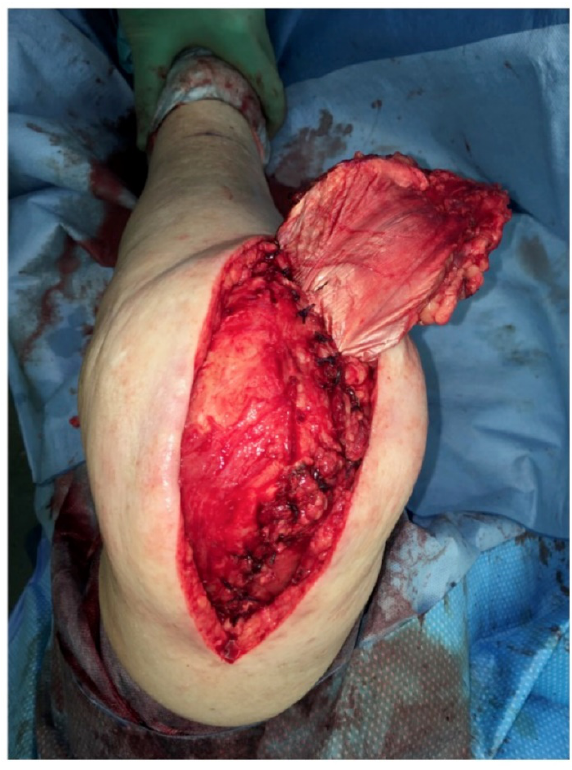
Figure 14: Pedicled MSAP gastrocnemius flap: Left knee in flexion while strengthening the medial capsule/patellar tendon lesion with the tendinous dorsal part of the flap (Table 1: Patient No. 5; additional Figures 6, 12, 13, 15, 16,